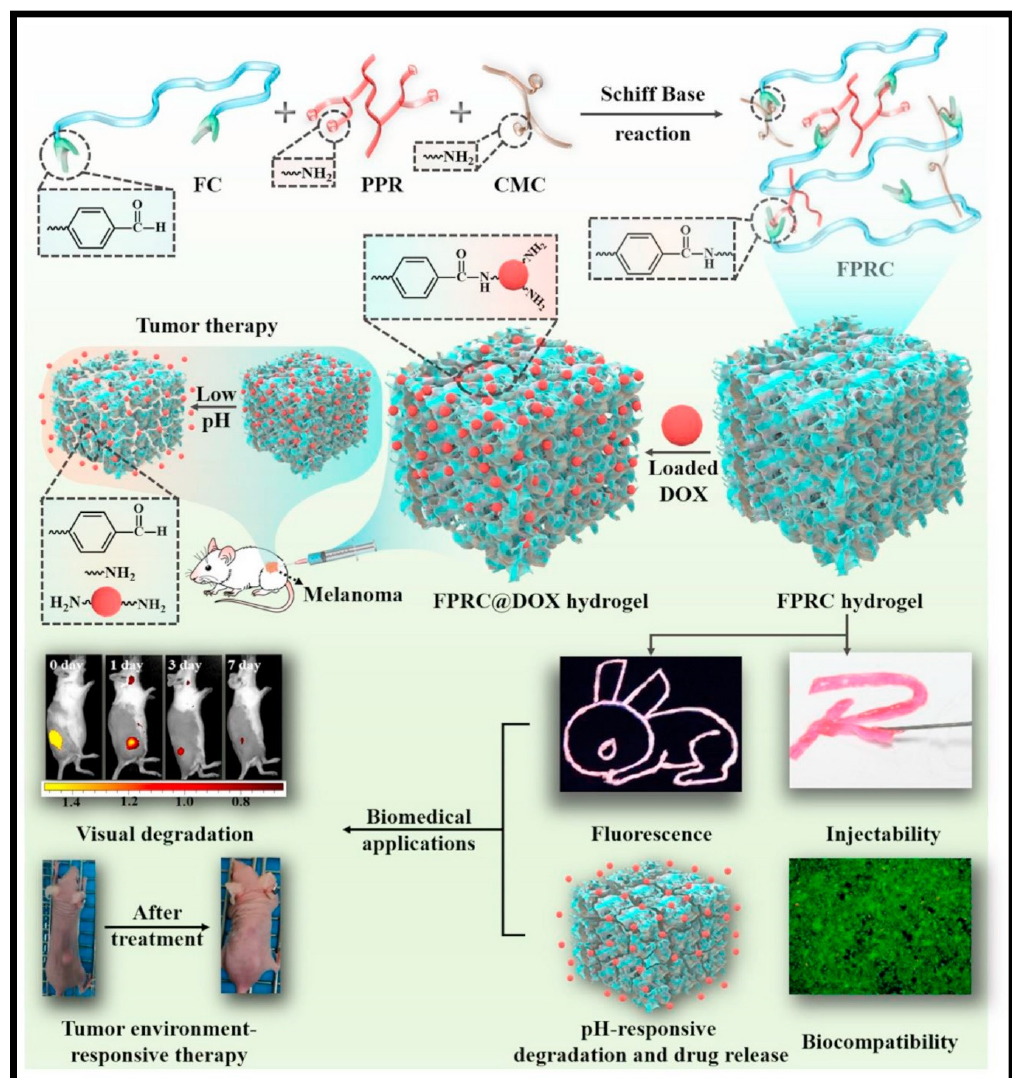
Figure 8. Schematic illustration on the method of fabrication of multifunctional FPRC Hydrogel and its multifunctional aspects like injectability, self-healing, photoluminescence, and pH-responsive degradation/drug release properties. (Reproduced with permission from Ref. [131]. Copyright 2020, Elsevier).